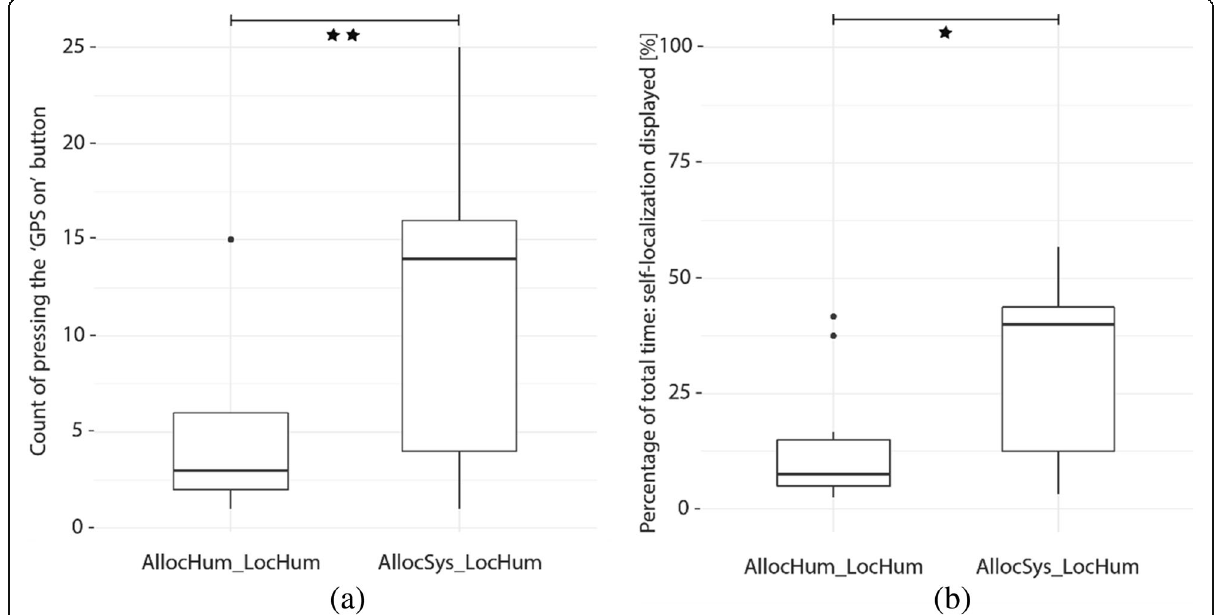
Fig. 6 Participants in group AllocSys_LocHum pressed the “ GPS on ” button more often than the group AllocHum_LocHum ( a ) . Distribution within and across groups of counting the instances of participants pressing the “ GPS on ” button (statistically significant difference, ** p < 0.01). Therefore, participants of the AllocSys_LocHum group had the self-localization displayed and accessible for a longer amount of time (statistically significant difference, * p < 0.05) ( b ). Black dots indicate